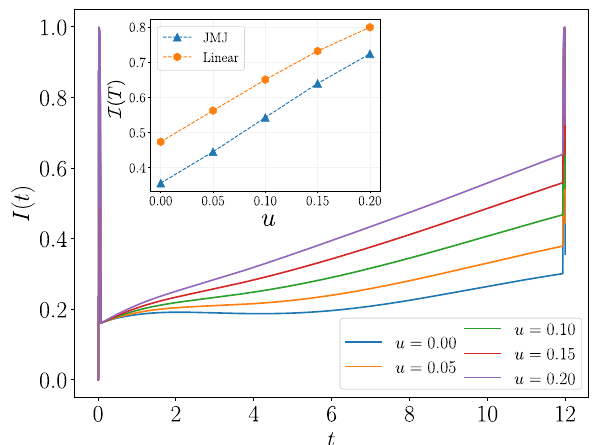
FIG. 7. Main panel: instantaneous infidelity I ( t ) of the opti- mal JMJ protocol from the noninteracting system in regime (I) run in a system with several different finite interaction strengths u . The jumps are robust against interactions whereas infidelity increases during the move part of the protocol. Inset: the final infidelity values I ( T ) increase approximately linearly with inter- action strength for both a linear as well as the best JMJ protocol. same as in Fig. 2 and the parameters of the JMJ protocol can be found in Appendix